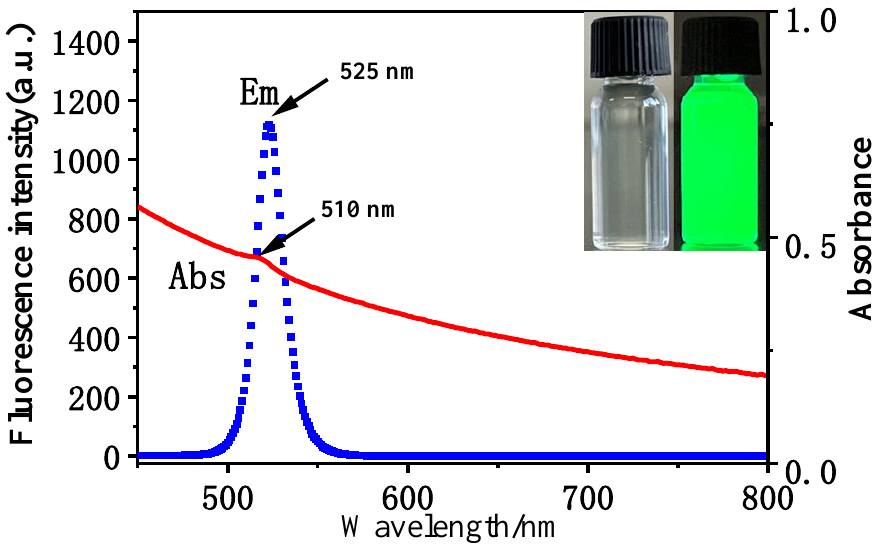
Figure 1. Fluorescence and UV absorption spectra of CsPbBr 3 /Cs 4 PbBr 6 PNCs. Inset: photos of the CsPbBr 3 /Cs 4 PbBr 6 PNCs under UV irradiation and natural light. Experimental conditions: synthetic precursors: CsBr (45.4 mM), PbBr 2 (45.4 mM), N-6-trifluoroacetyl-L-lysine (4.54 mM), reaction time: 2.5 h, reaction temperature: − 18 ◦ C. Synthesis of CsPbBr 3 /Cs 4 PbBr 6 PNCs: OLA (250 µ L), precursor (1.375 mL). Reaction time: 20 min. Reaction temperature: 25 ◦